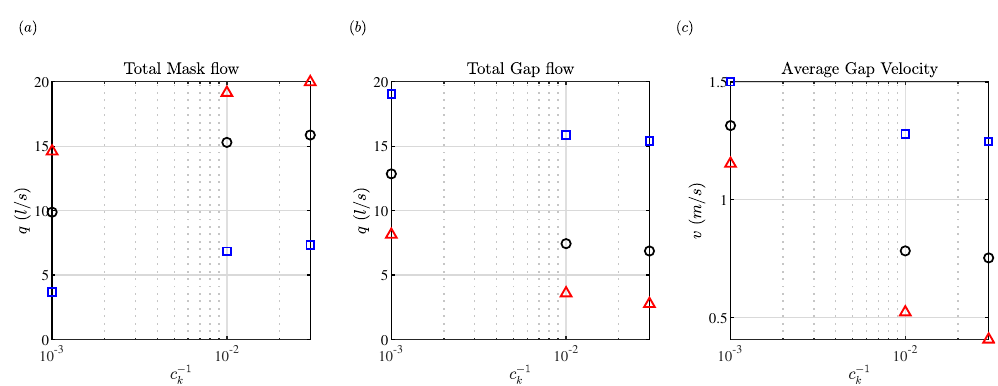
Figure 6. Volume flow rates for different mask porosities. ( a ) through the mask, ( b ) through the peripheral gaps, and ( c ) the average velocity through the top gap for female ( (cid:3) ), male ( (cid:13) ), and child ( (cid:52) )